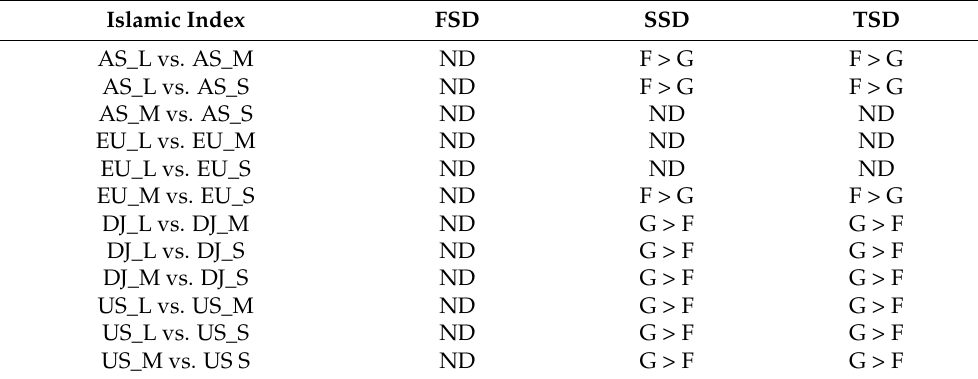
Table 7. Descending Stochastic dominance (DSD) results of Davidson and Duclos test: sub-period 2